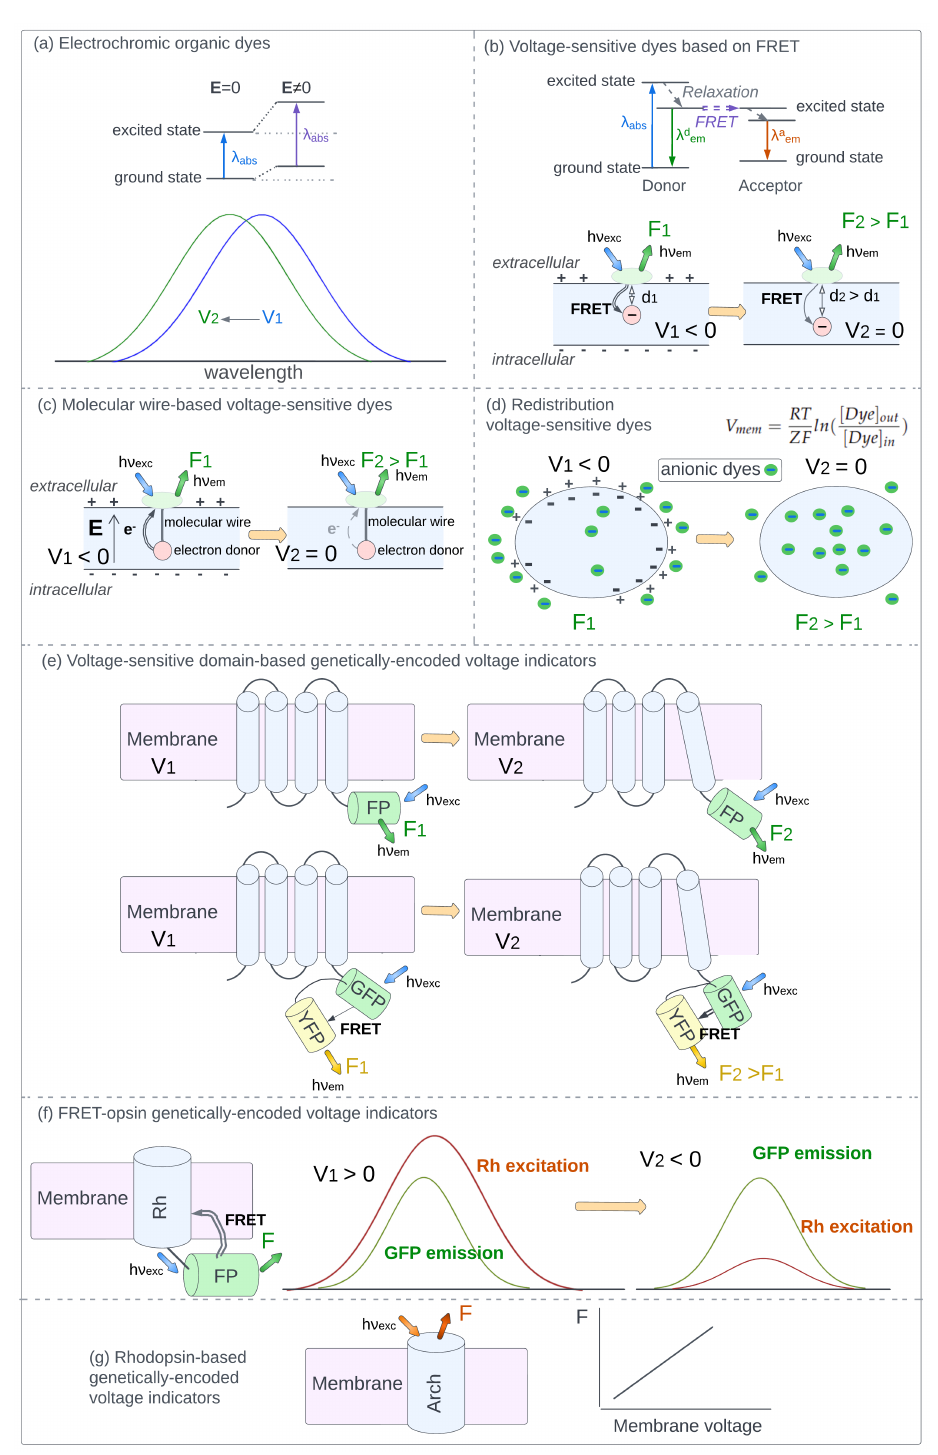
Figure 1. Commonly-used classes of molecular and biomolecular potentiometric sensors. ( a ) Elec- trochromic organic dyes. Upper. Electrochromic organic dyes are characterized by different electron distributions in the ground and excited states. Interaction with an external electric field E alters the energies of the ground and excited states to a different extent, resulting in the shift of absorption, excitation and emission bands. Lower . Spectral shift of electrochromic dye upon membrane voltage change can be utilized for membrane potential imaging. The depicted band can represent absorption, excitation, or emission spectral band. ( b ) FRET-based organic dyes. Upper. Fluorescence resonance energy transfer (FRET) can occur between two molecules (donor and acceptor) with